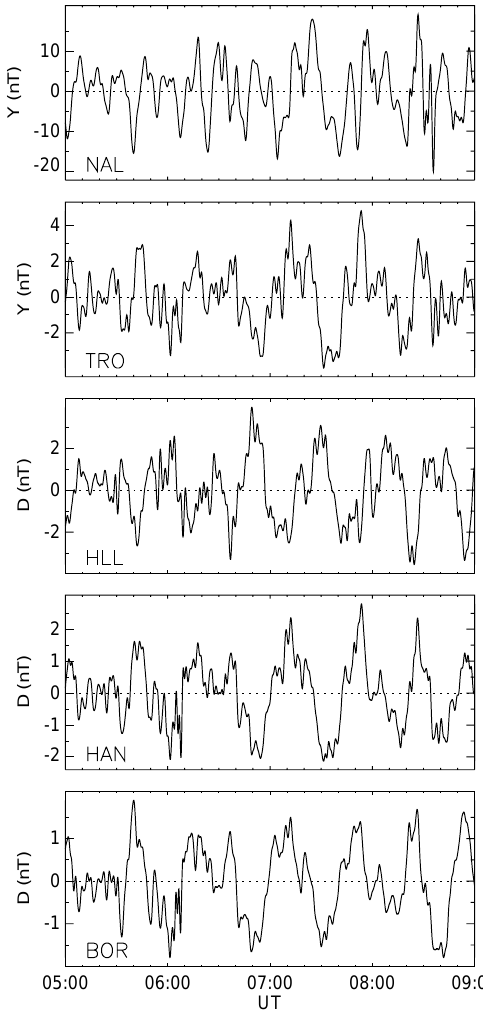
Fig. 11. East-west component magnetograms from stations of the SAMNET and IMAGE magnetometer networks, bandpass filtered to reveal oscillations with periods between